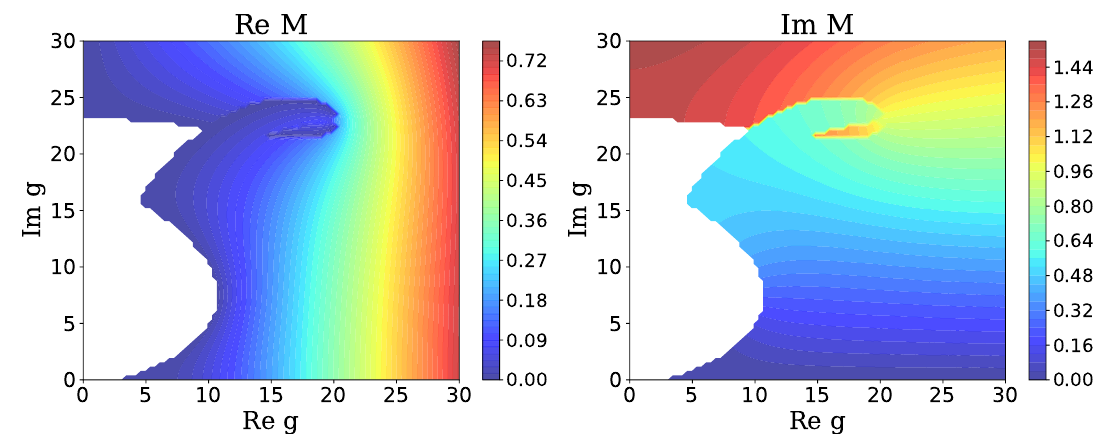
Figure 5. The real and imaginary parts of the complex dynamical mass M for